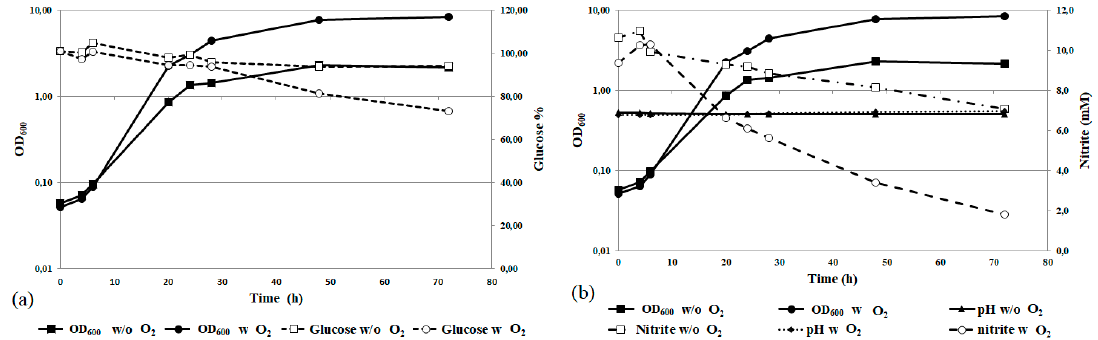
Figure 6. R. diobovata DSBCA06 growth in YNB using a bioreactor, with and without aeration. Glucose removal is reported in panel ( a ); whereas nitrite removal and pH measurements in ( b ).